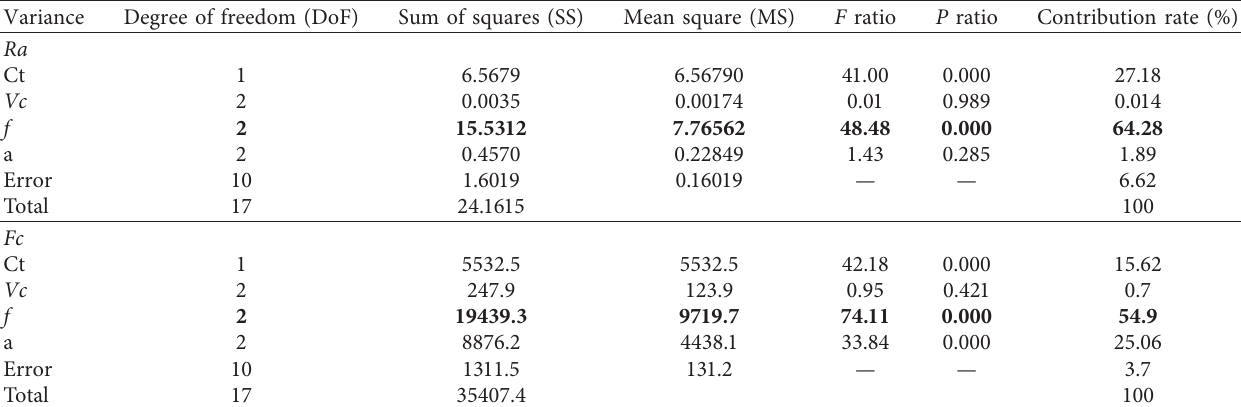
Table 6: Results of ANOVA for Ra and Fc.